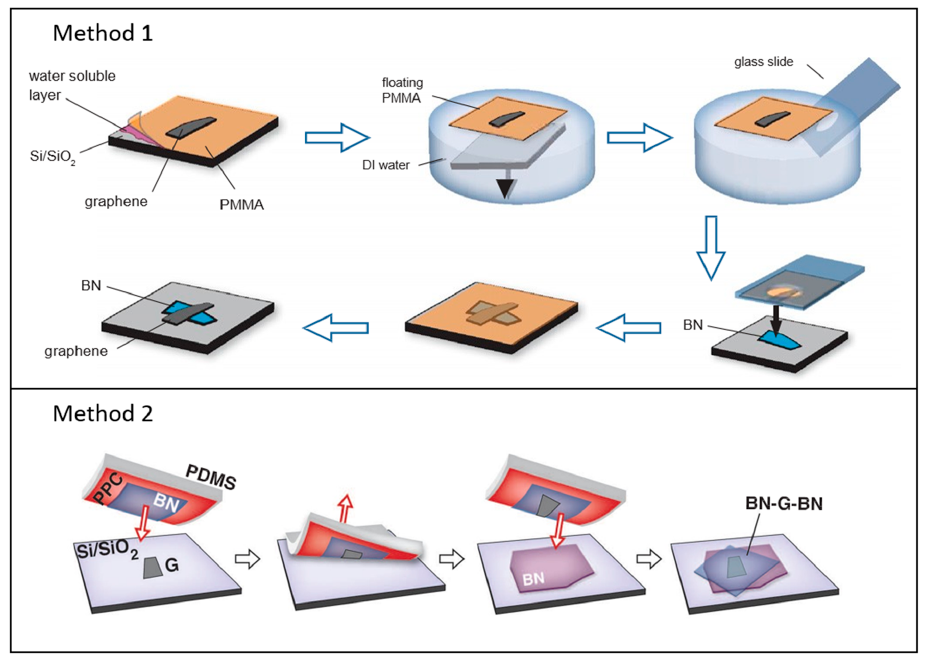
Figure 4. Representative methods for fabricating 2D vdW heterostructures (i.e., graphene/ h ‐ BN